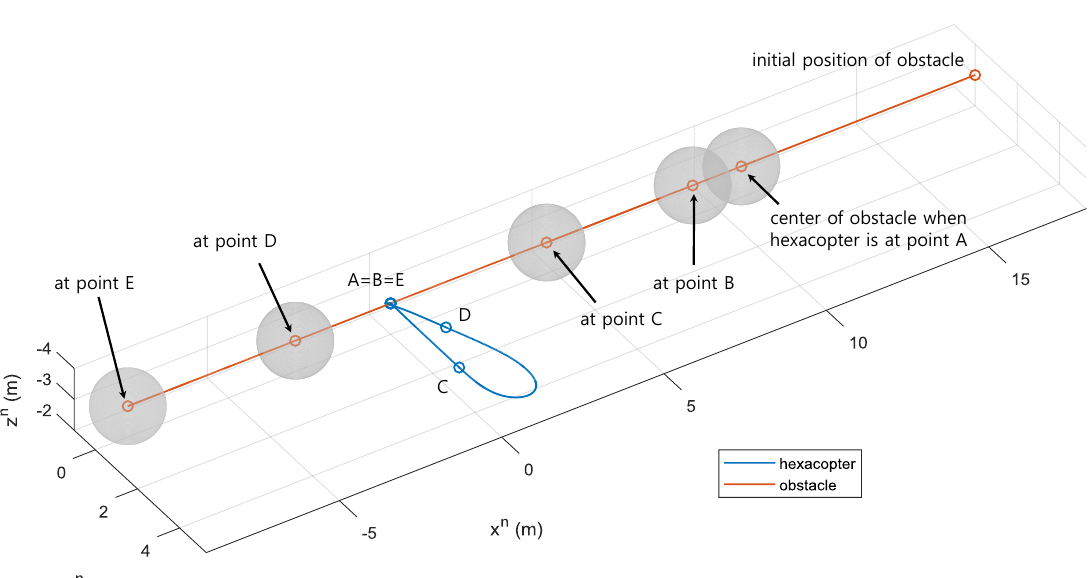
Figure 6. Trajectories of the hexacopter and the obstacle (azimuth: − 33 ◦ , elevation: 37 ◦ , Simulation I). Additionally, Figure 7 shows the time responses of the attitude, angular velocity, velocity, and absolute velocity of the hexacopter, and the minimum distance between the UAV and the obstacle. Also, Figure 8 shows the time responses of the estimated state along with the true state plotted as a reference of comparison. Note that all state estimates are set to zero at initial